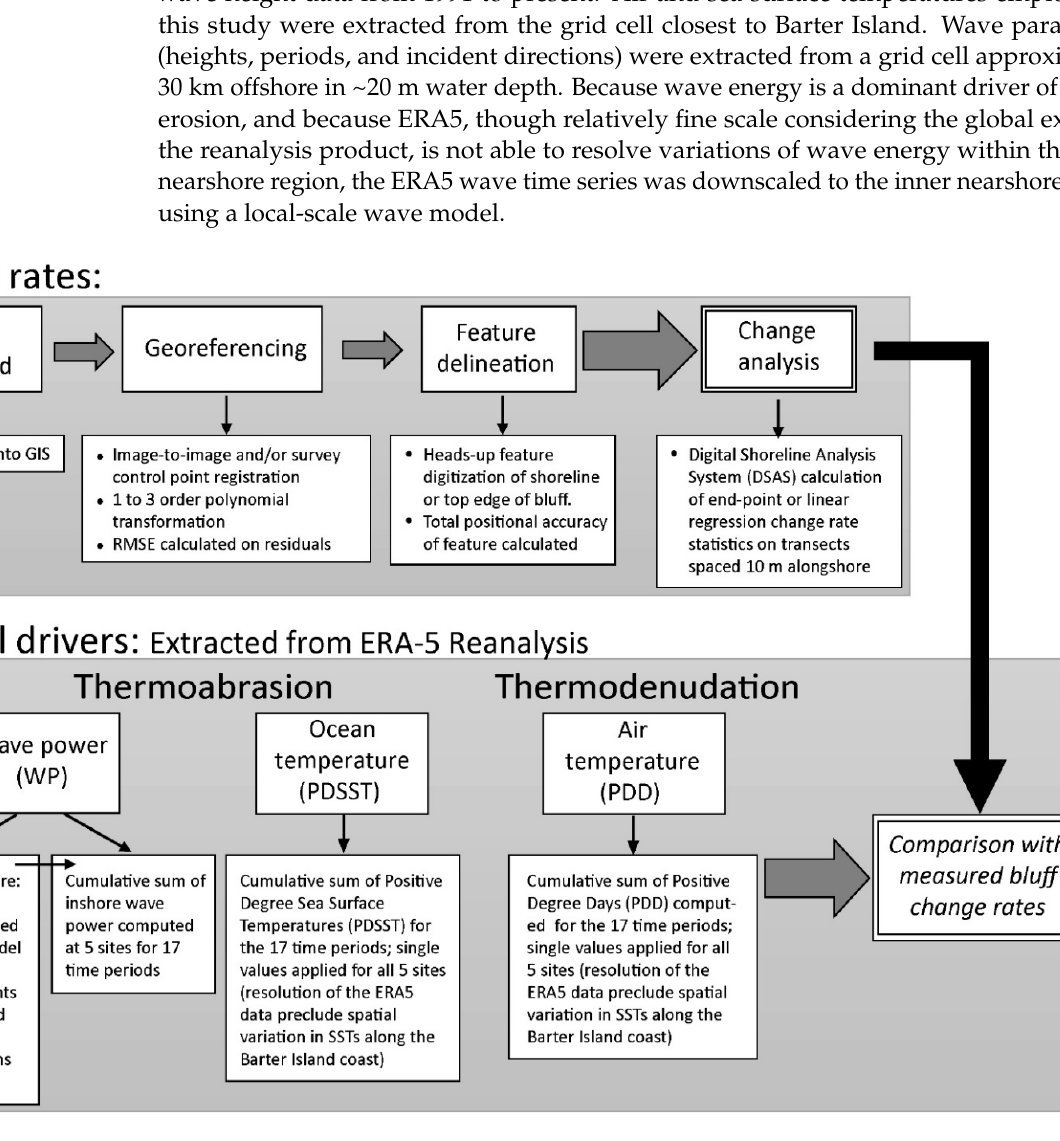
Figure 2. Flow chart outlining the study methodologies.